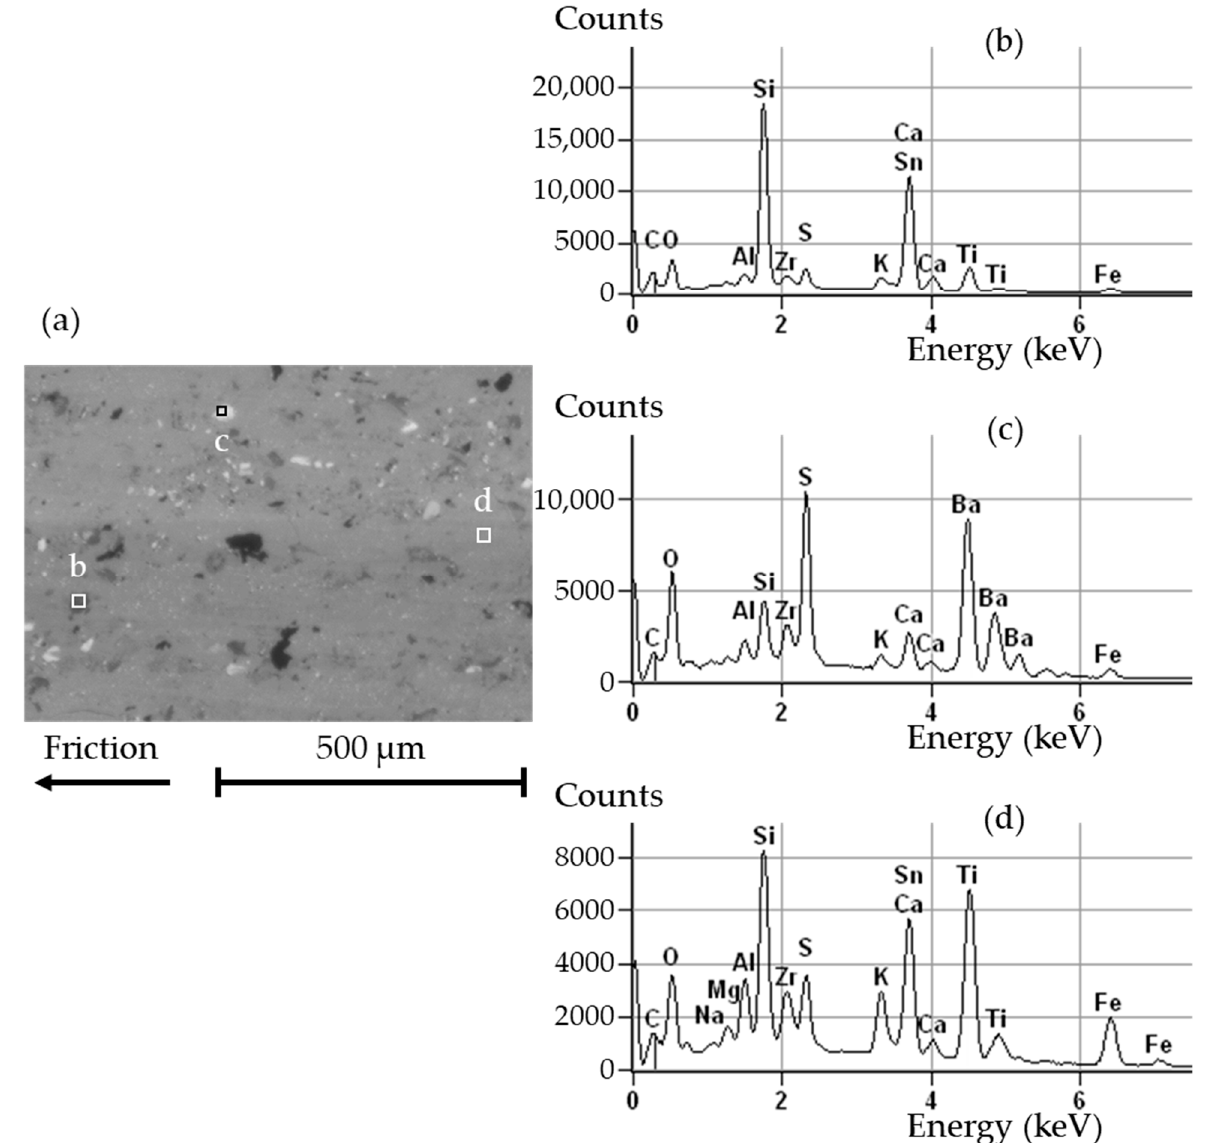
Figure 13. Worn surface of an NAO pad: ( a ) SEM backscattered electron image; ( b – d ) EDS spectra corresponding, respectively, to the areas labeled as b, c, and d in ( a ) (accelerating voltage 20 kV, working distance 15.3 mm).